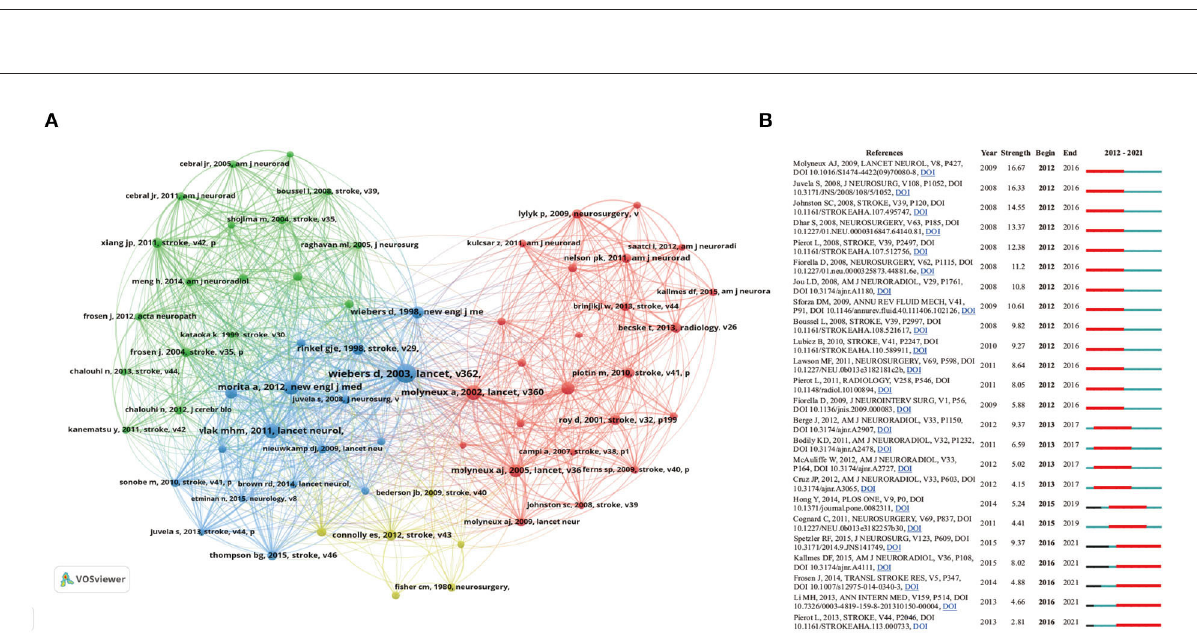
FIGURE7 (A) The co-citation references network on IA studies from 2012 to 2021. (B) The top 24 references with the strongest citation bursts on IA studies from 2012 to 2021 were displayed by CiteSpace. The blue line represents the time from its first appearance to 2021, and the red line represents the burst